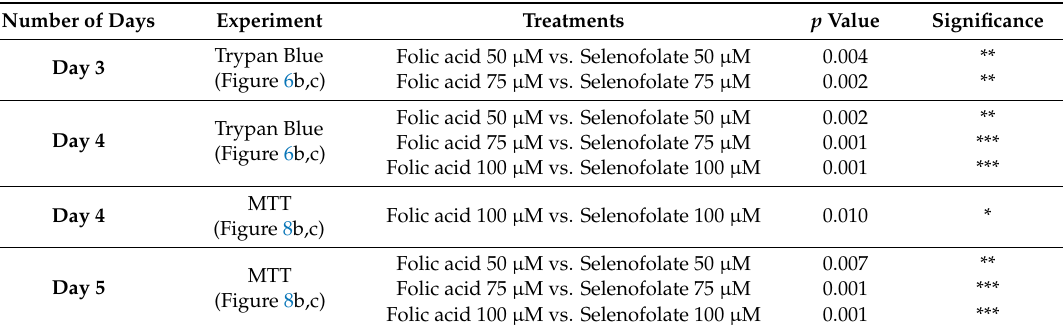
Table 2. Statistical analyses of the e ff ects of Folic acid and Selenofolate treatments on HME50-5E cells. Number of Days